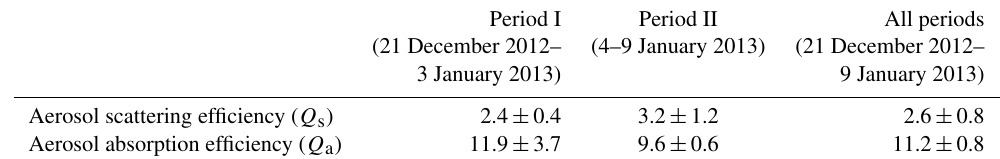
Table 2. Aerosol mass scattering efficiency (at 550nm) and aerosol mass absorption efficiency (at 520nm) for each period and all